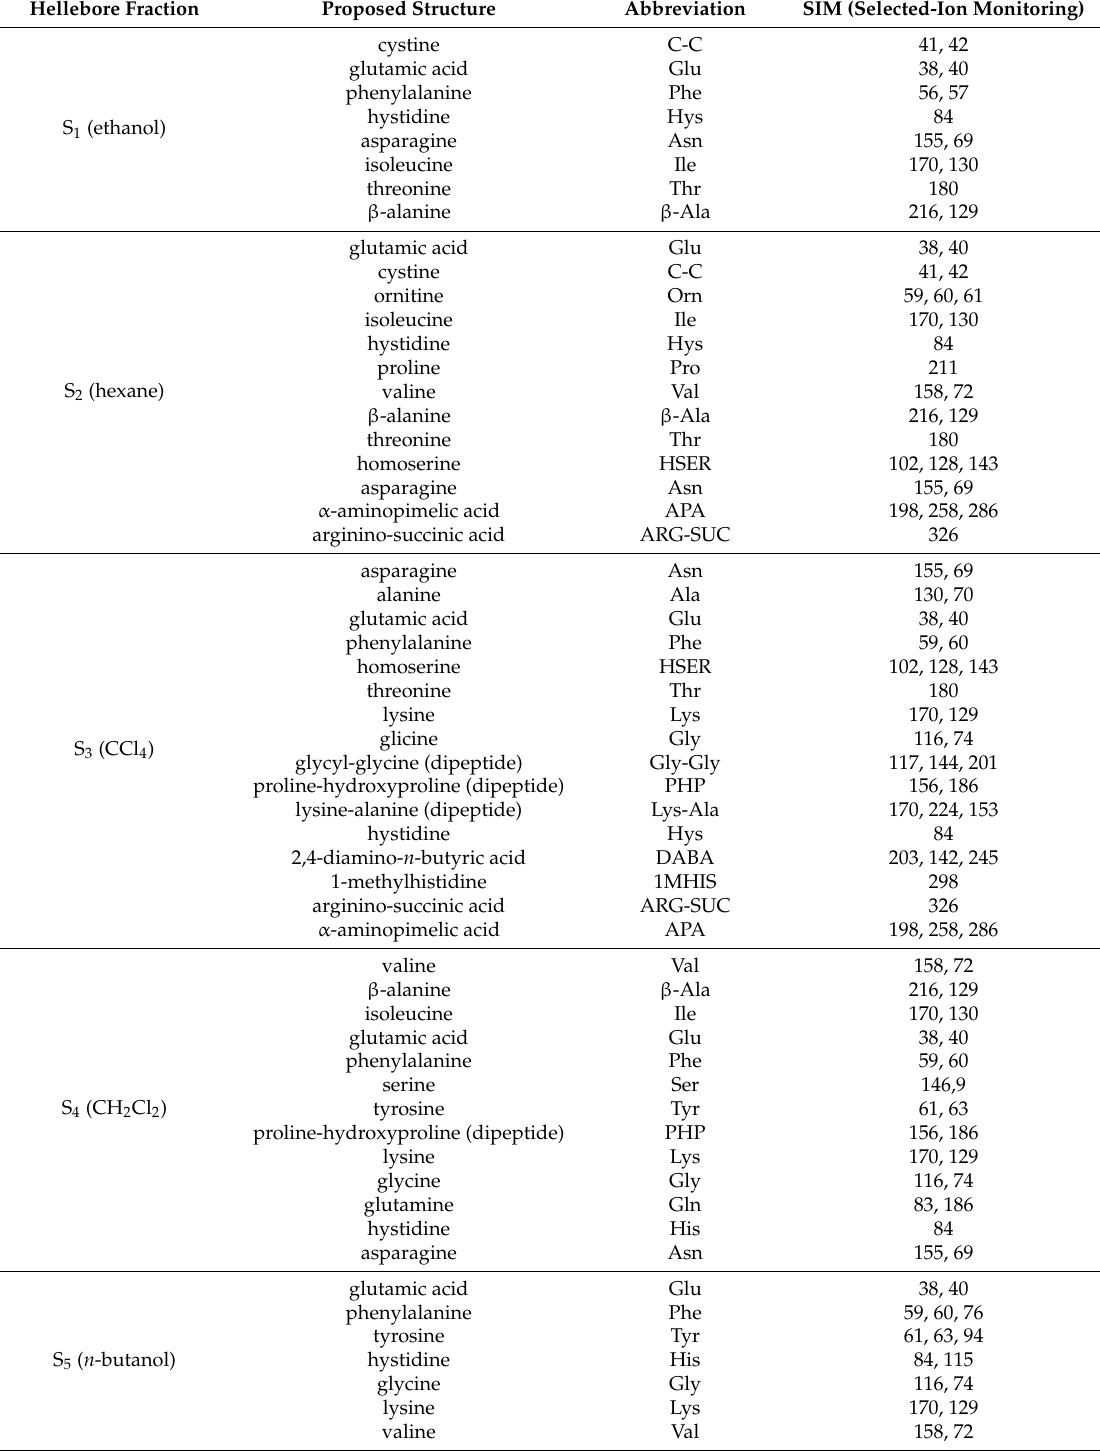
Table 2. GC-MS amino acid